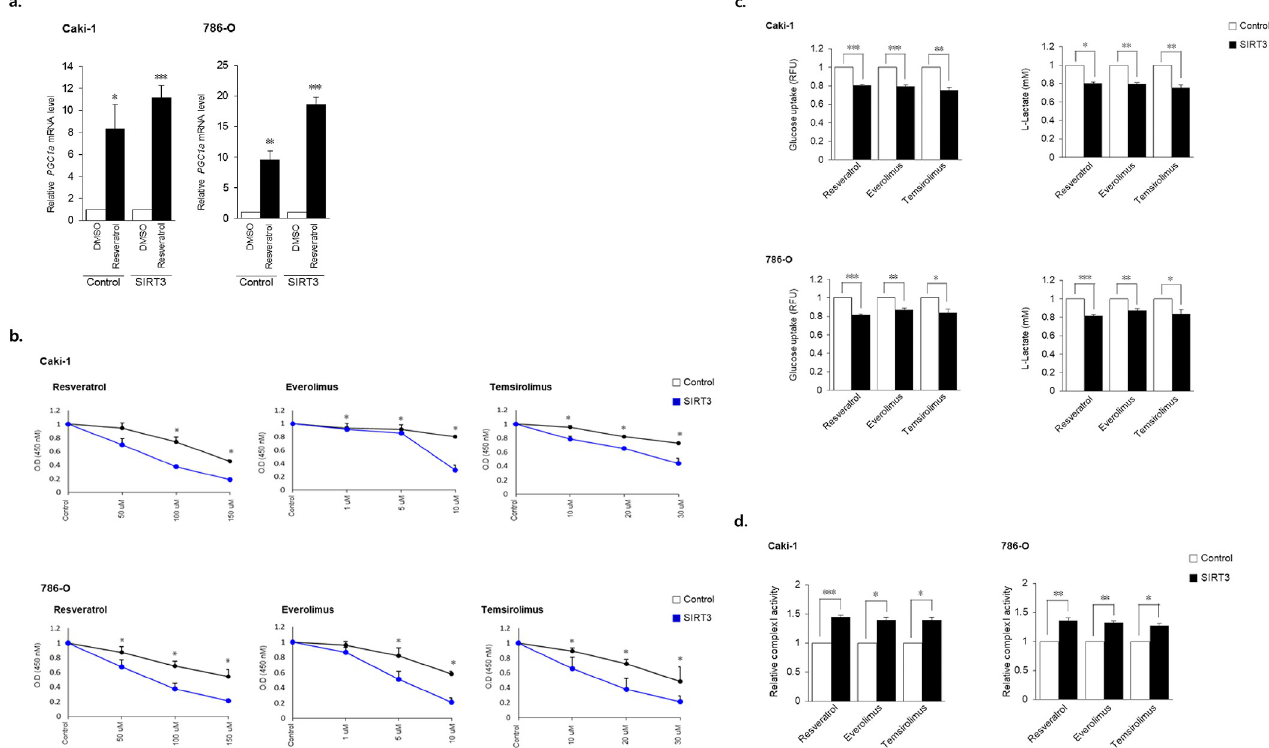
Fig 3. SIRT3 overexpression and resveratrol treatment improved PGC1 α expression in ccRCC cells. a. SIRT3-overexpressing cells were treated with RSV. PGC1 α mRNA levels were quantified using qRT-PCR. Values are expressed as mean ± SEM (n = 4, per triplicate) and control-cell values were set to 1. b. Anticancer drugs induce anti-proliferative effects and mitochondrial function in ccRCC cells (Black line: empty vector, blue line: SIRT3 expression vector). The proliferation of ccRCC cells was determined using a CCK-8 assay kit. Cells were treated with drugs for 48 hr after SIRT3 overexpression. Data are expressed as mean ± SEM (n = 5, per triplicate) and compared to controls. c. Glucose uptake (n = 4, per triplicate) and L-lactate production (n = 3, per triplicate)in ccRCC cells with and without drug treatments. Cells were treated with drugs for 48 hr after SIRT3 overexpression. Data are expressed as mean ± SEM and control-cell values were set to 1. � p < 0.05, �� p < 0.01, ��� p < 0.001. d. Quantitative analysis of mitochondrial complex I enzyme activity in ccRCC cells with and without drug treatments. Data are expressed as mean ± SEM (n = 3, per triplicate) and control-cell values were set to 1. � p <